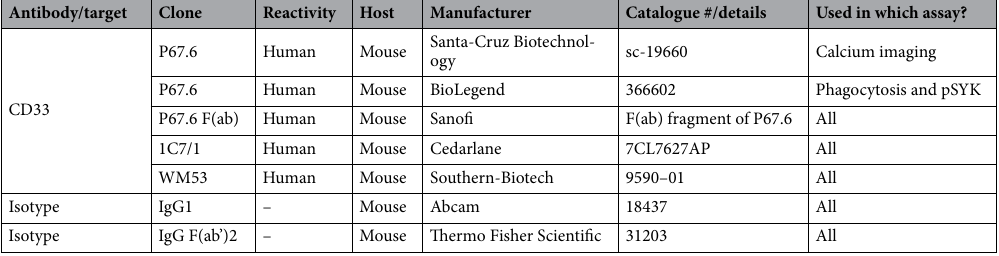
Table 1. CD33-specific and control